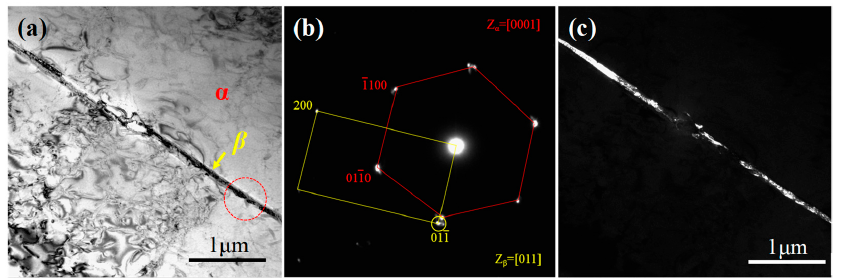
Figure 2. TEM images of the initial CG Ti sample: ( a ) light filed image, ( b ) select electron diffraction pattern, and ( c ) the corresponding dark filed image.